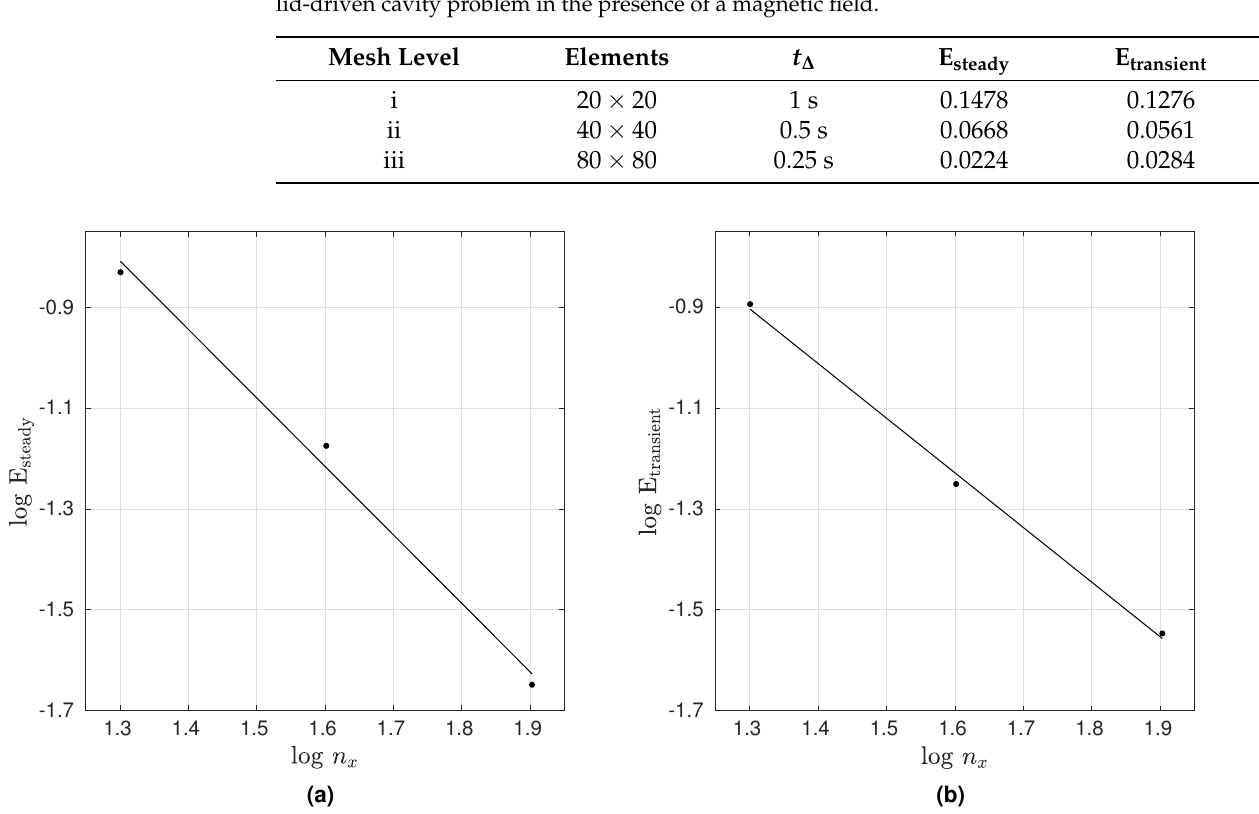
Table 1. Convergence of the solution with respect to mesh and timestep refinement in the 2D lid-driven cavity problem in the presence of a magnetic field.